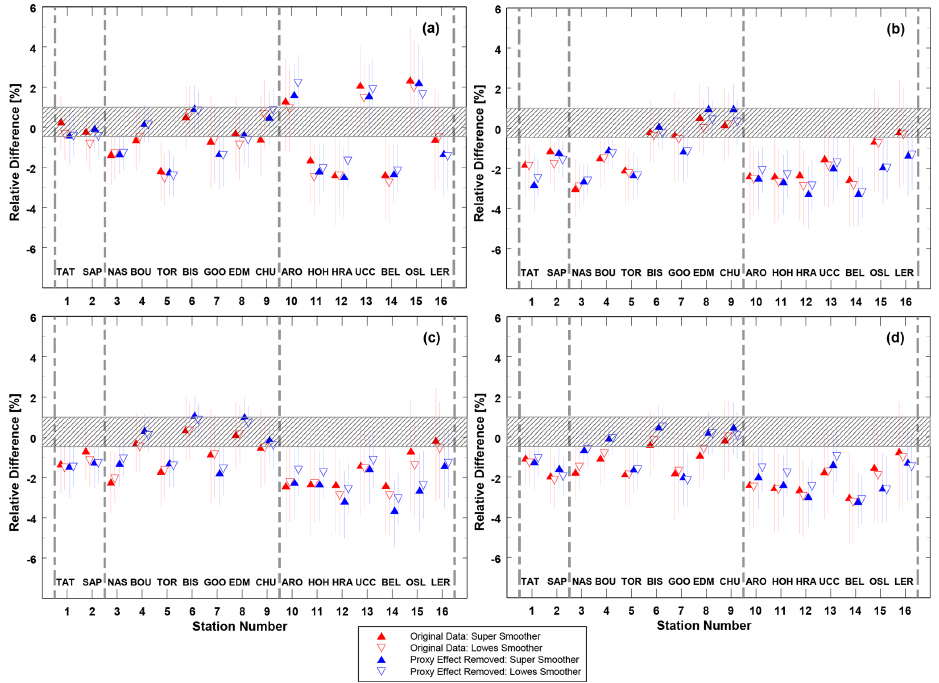
Figure A1. The same as Fig. 4 but for the ozone recovery index, ORI 1 (1988 , 2020), based on the TCO 3 monthly means averaged over the entire year (January–December).